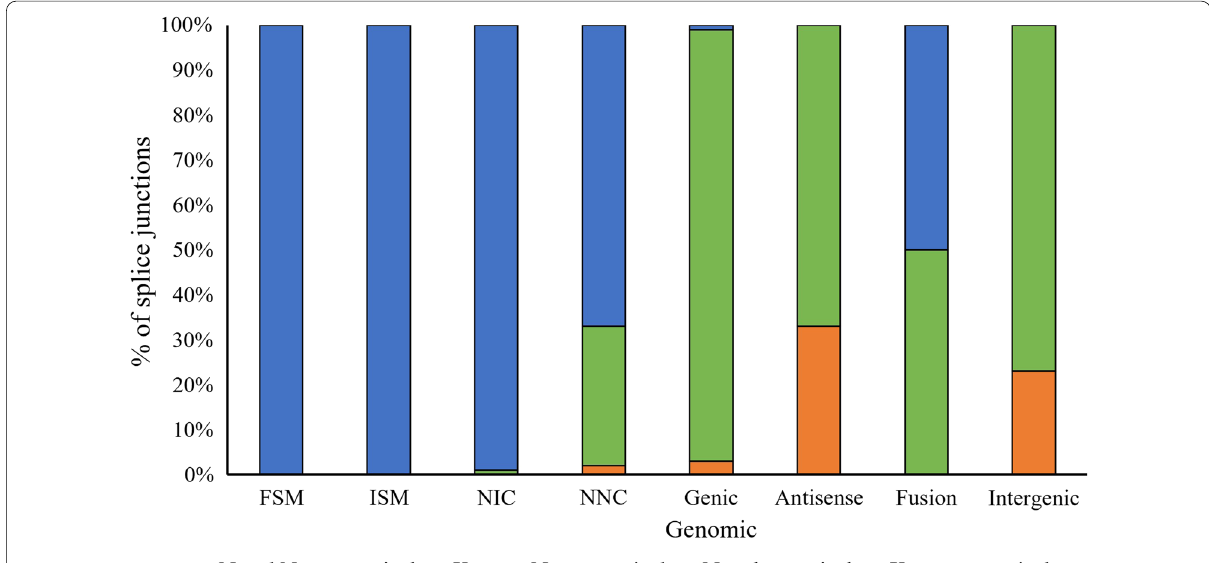
Fig. 4 Distribution of alternative splice junction across all the isoform